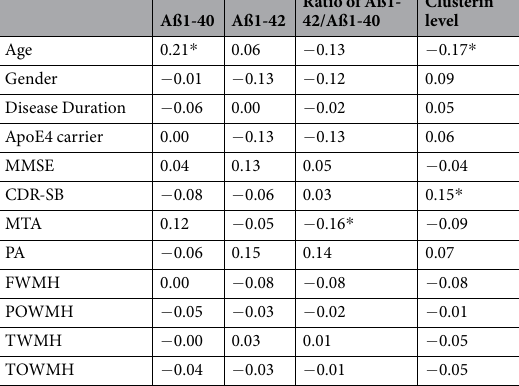
Table 3. Correlations of plasma biomarker, demographics, disease characteristics and brain MRI visual rating scores in patients with AD. Values are Pearson correlation coefficients. MRI, magnetic resonance imaging; AD, Alzheimer’s disease; Aß, amyloid ß peptide; ApoE4, apolipoprotein E4; MMSE, Mini-Mental State Examination; CDR-SB, clinical dementia rating sum of boxes; MTA, medial temporal atrophy; PA, posterior atrophy; FWMH, frontal white matter hyperintensity; POWMH, parieto-occipital white matter hyperintensity; TWMH, temporal white matter hyperintensity; TOWMH, total white matter hyperintensity. * p <